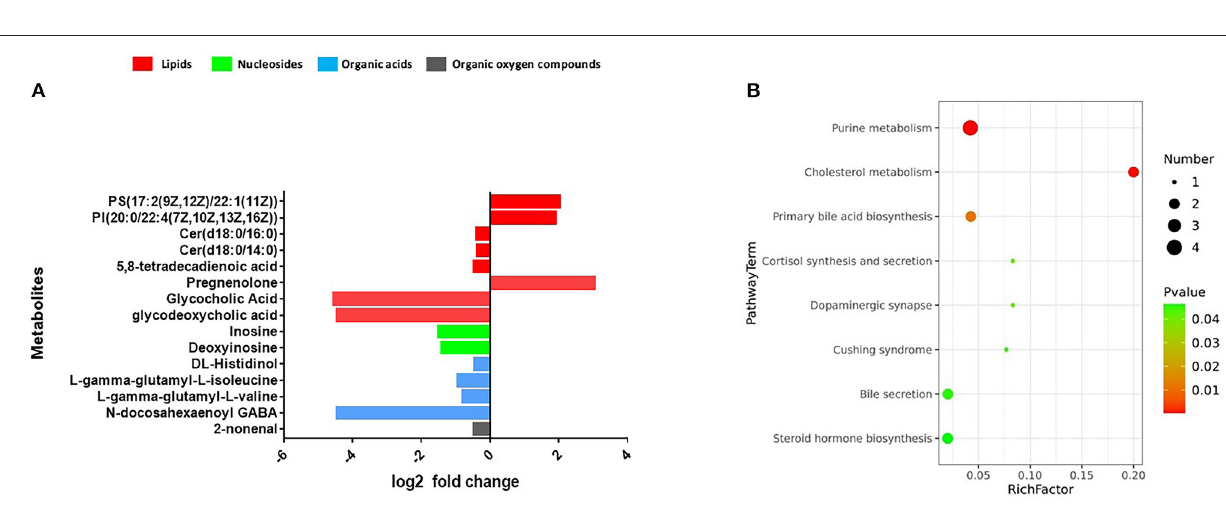
The significantly perturbed pathways are shown in Figure 6B